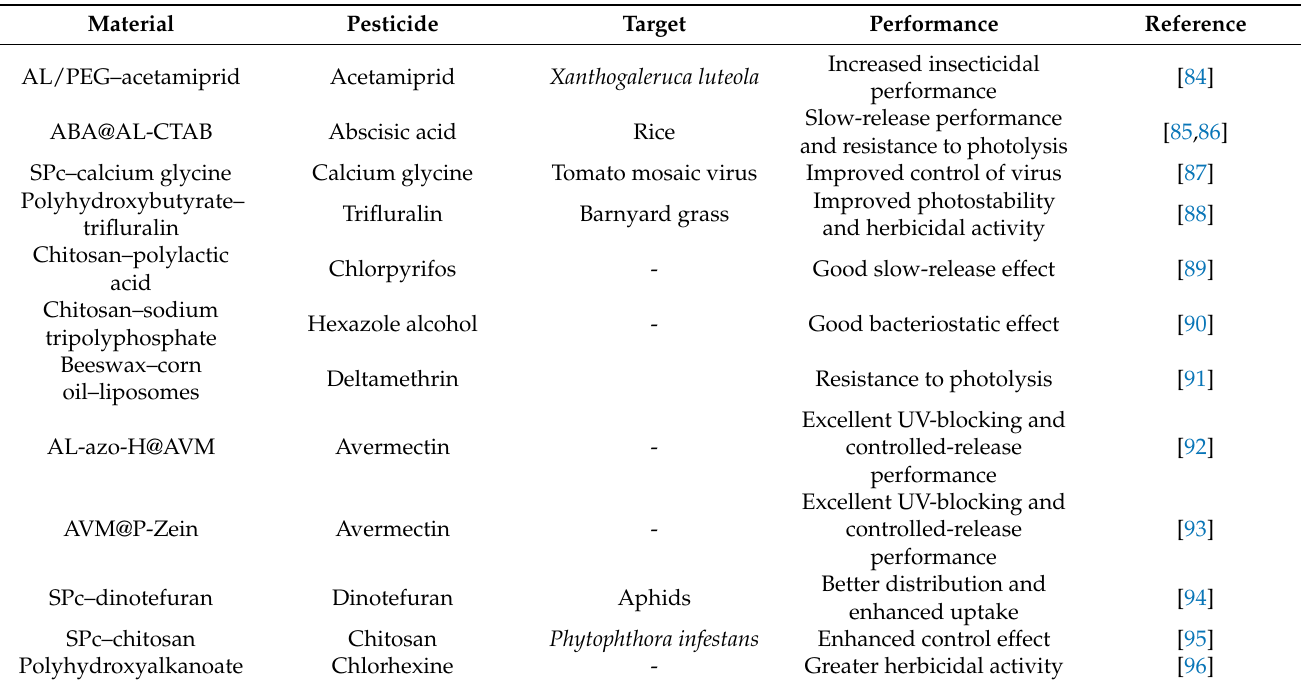
Table 2. Nanopesticides prepared from organic